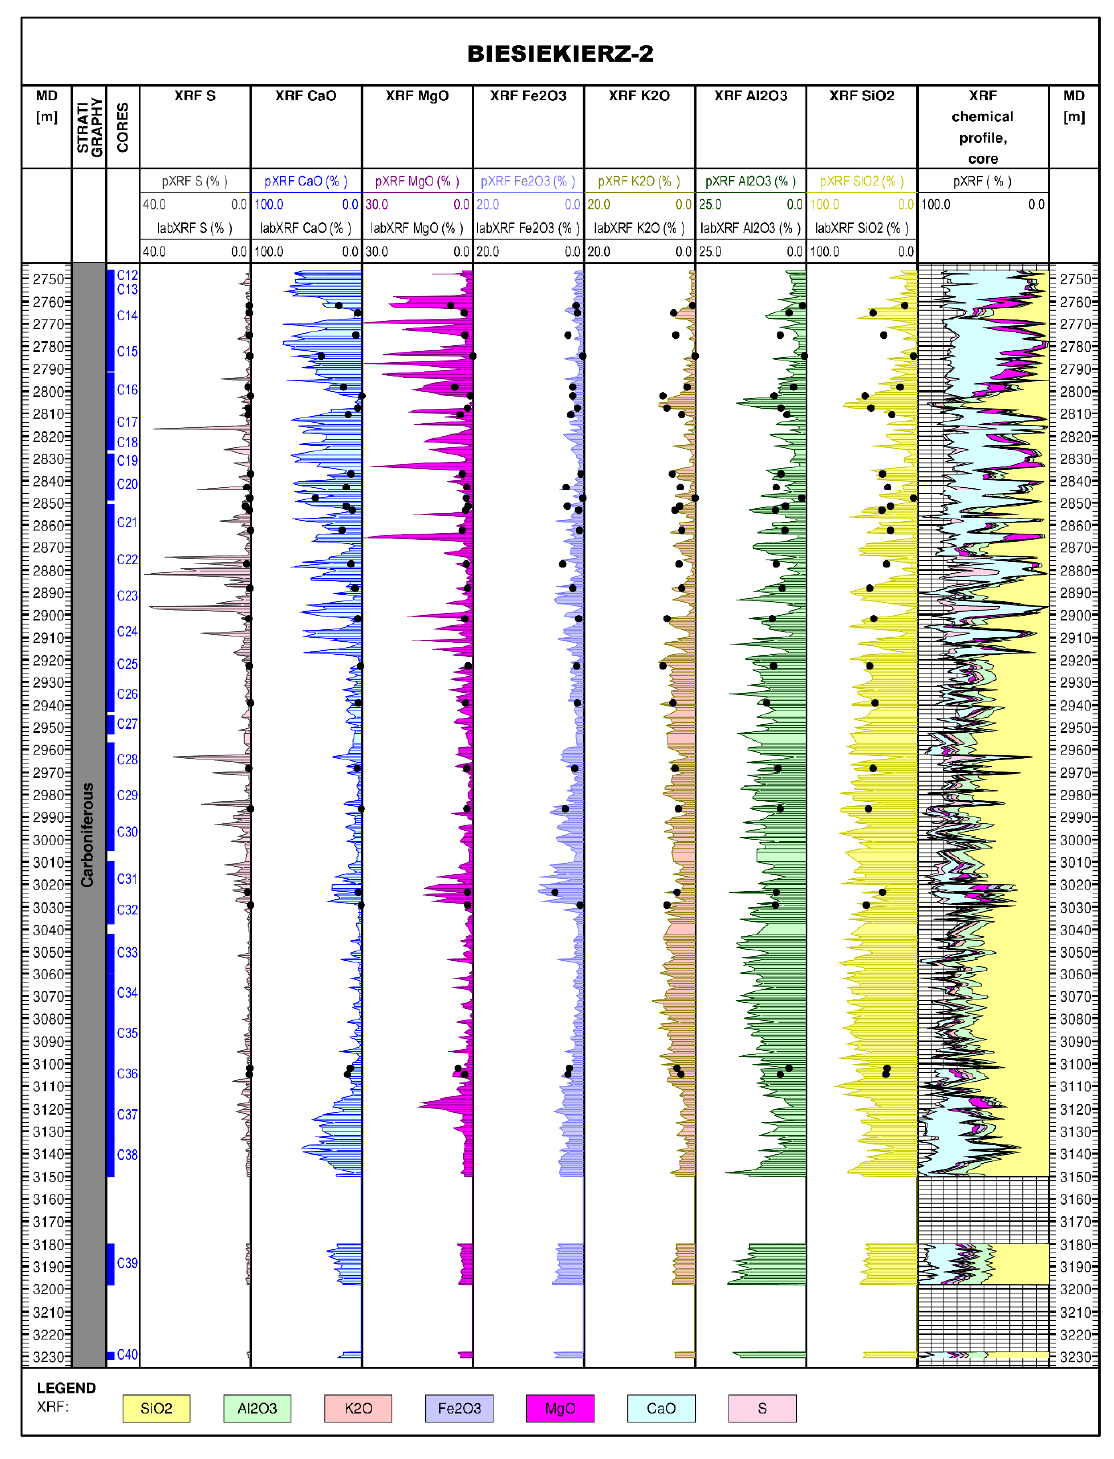
Figure 13. Table of results regarding XRF measurements taken on core samples in the Biesiekierz-2